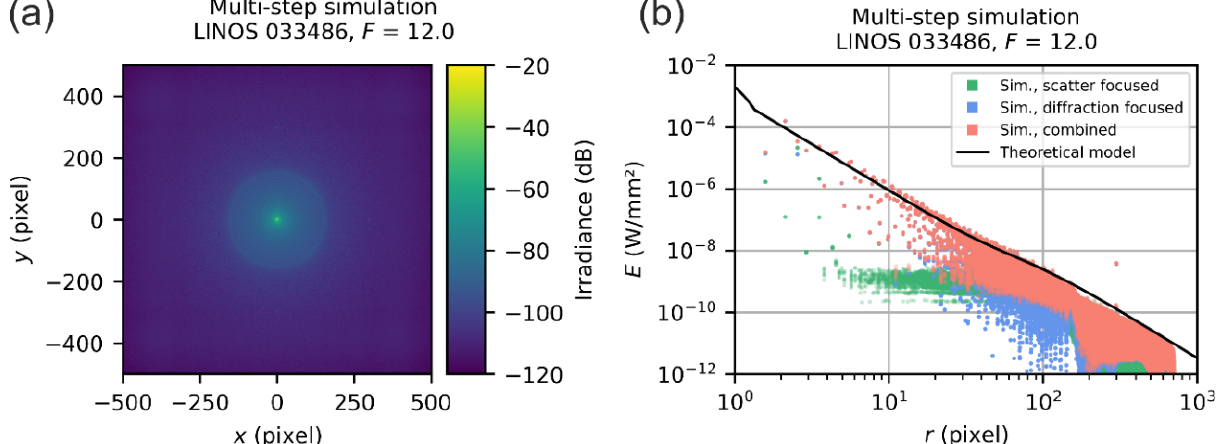
Figure 13. Simulation results for the combination of two simulation results for the LINOS 033486 lens when setting an f-number of F = 12: Green data points: simulation using the scatter-focused parameter set 2, blue data points: simulation using the diffraction-focused parameter set 3, red data points: combined simulation results. ( a ) Results represented as an image. ( b ) Results shown as a scatter plot.